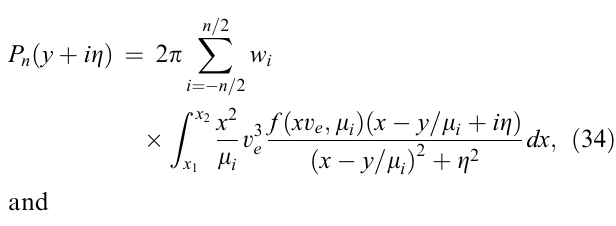
Fig. 6. On the left, the real and imaginary parts of the Z n function for same complex argument as in Fig. 5. On the right, their relative error with the real and imaginary parts of the W function (Ichimaru, 1992). The normalized Doppler shift of the Maxwellian distribution is x d (cid:136) 0